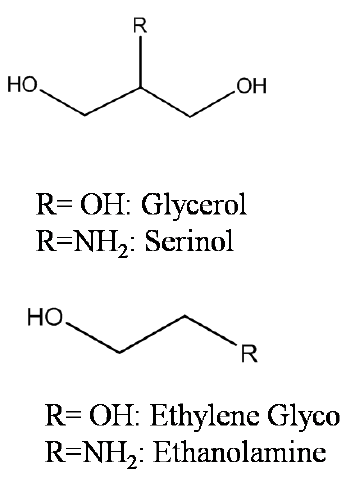
Figure 1. Polyols and amino alcohols